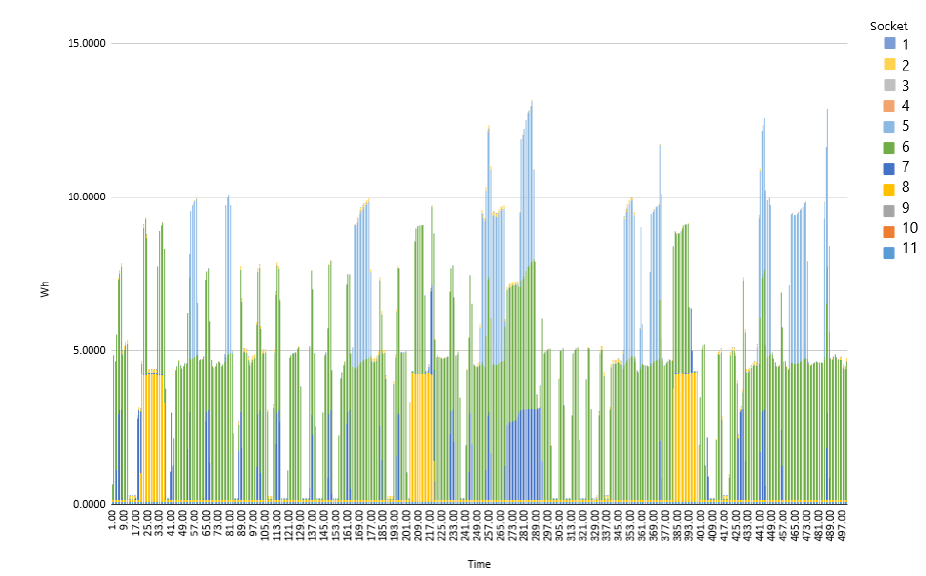
Figure 12. Manual consumption scheduling of recurrent consumption cycle of 11